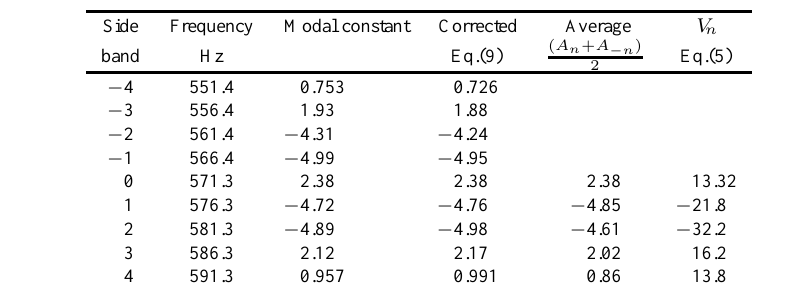
Fig. 3. Fixed-point FRF of the plate shown in Fig. 4. Table 1 Derivation of (unscaled) mode